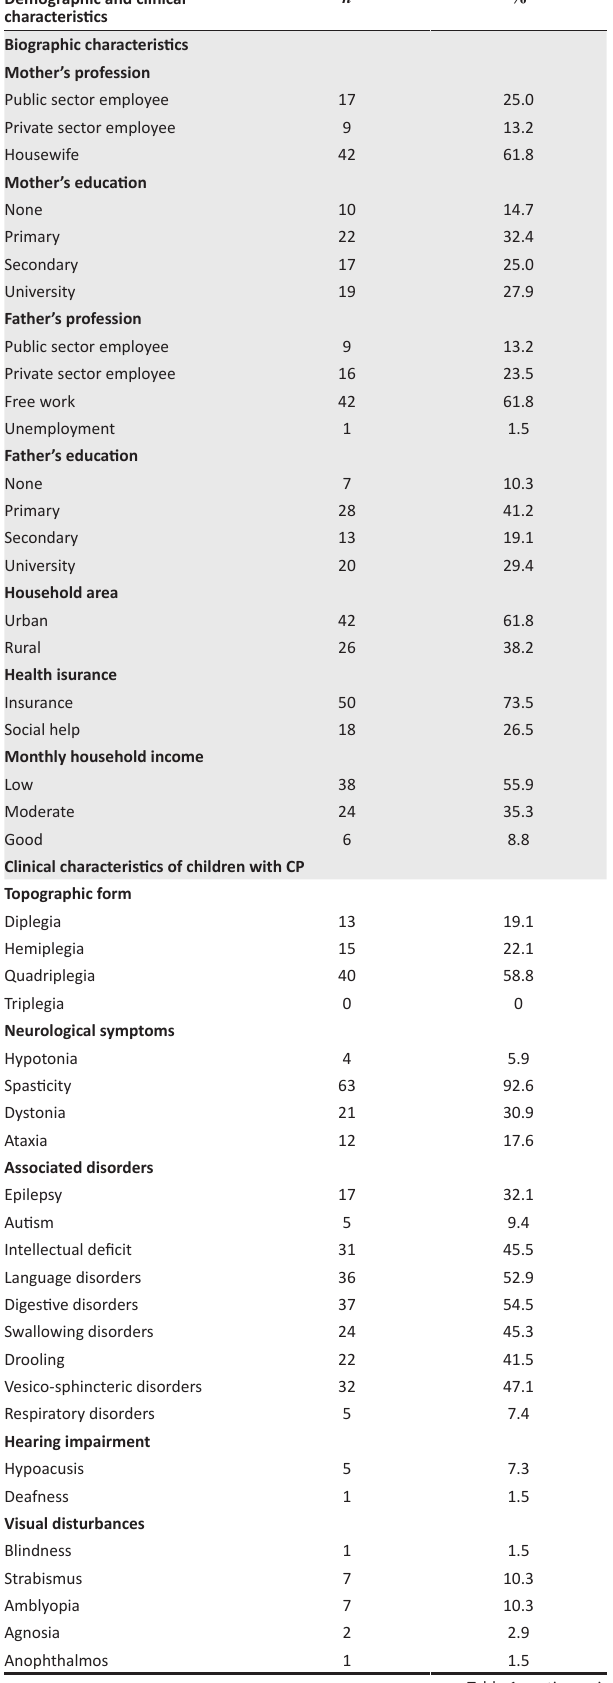
TABLE 1: Biographical information of children with cerebral palsy and their families ( N = 68). Demographic and clinical characteristics